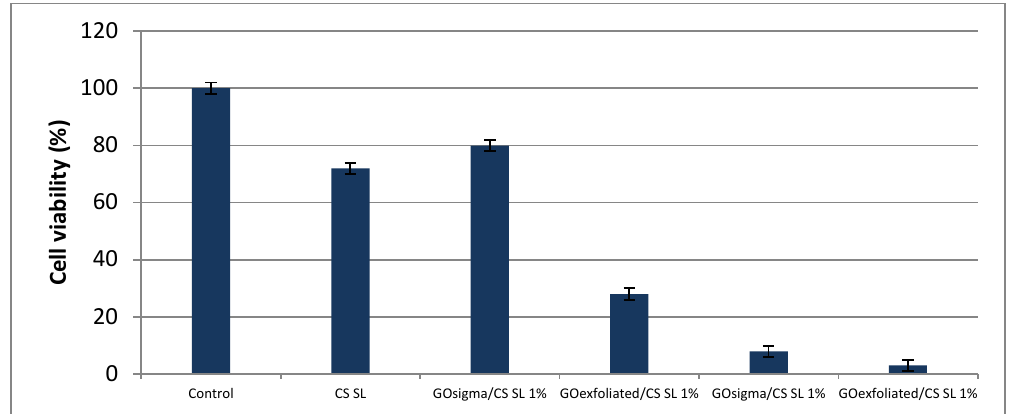
Figure 9. Cell viability on CS and composite scaffolds.